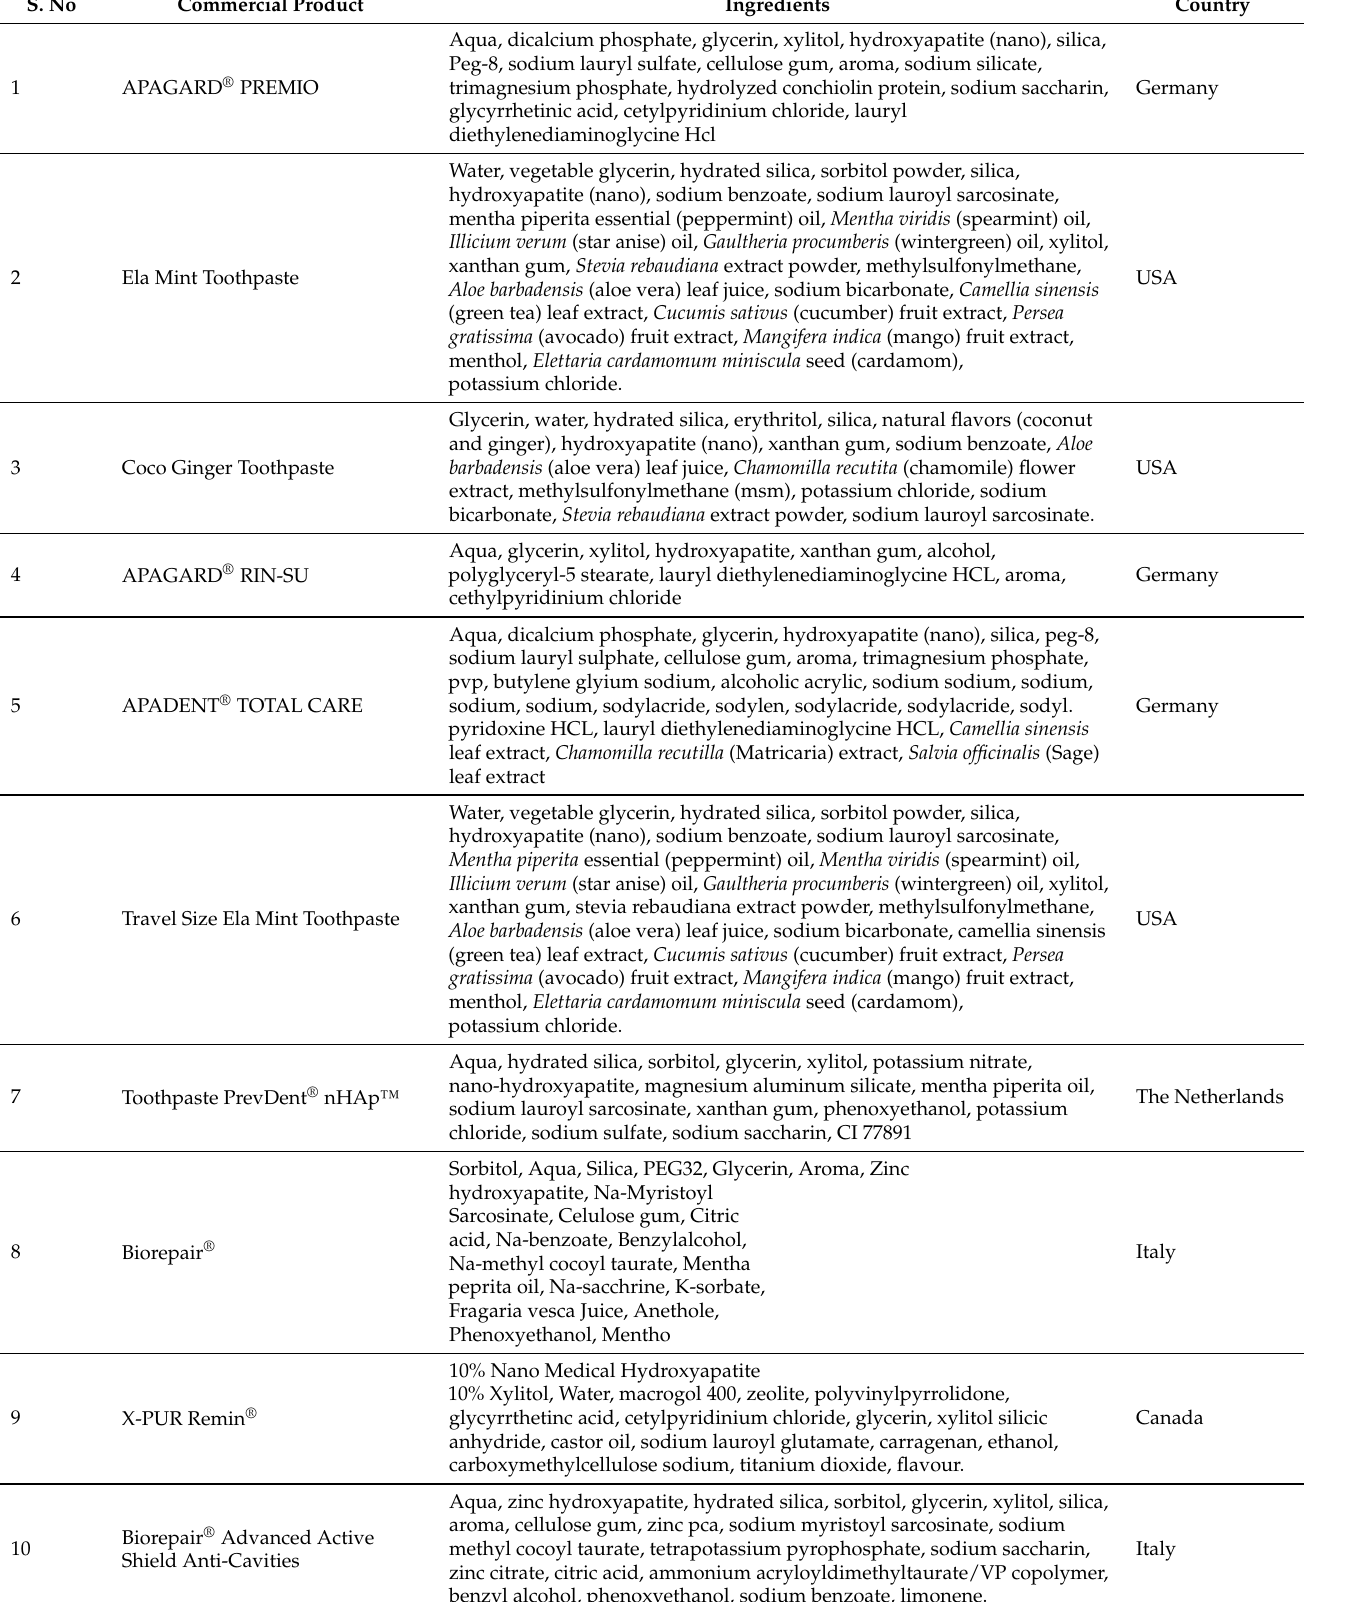
Table 1. Commercial toothpaste based on hydroxyapatite